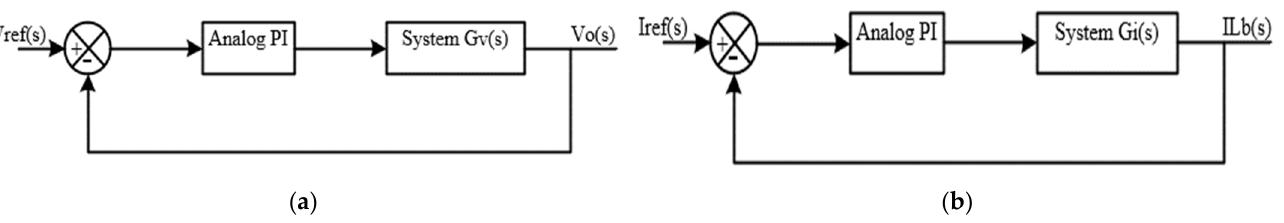
Figure 9. Block diagrams of the closed loop control systems: ( a ) outer voltage loop; ( b ) inner current loop. For the voltage control loop; the TF of the outer voltage system G v (s) in s-domain